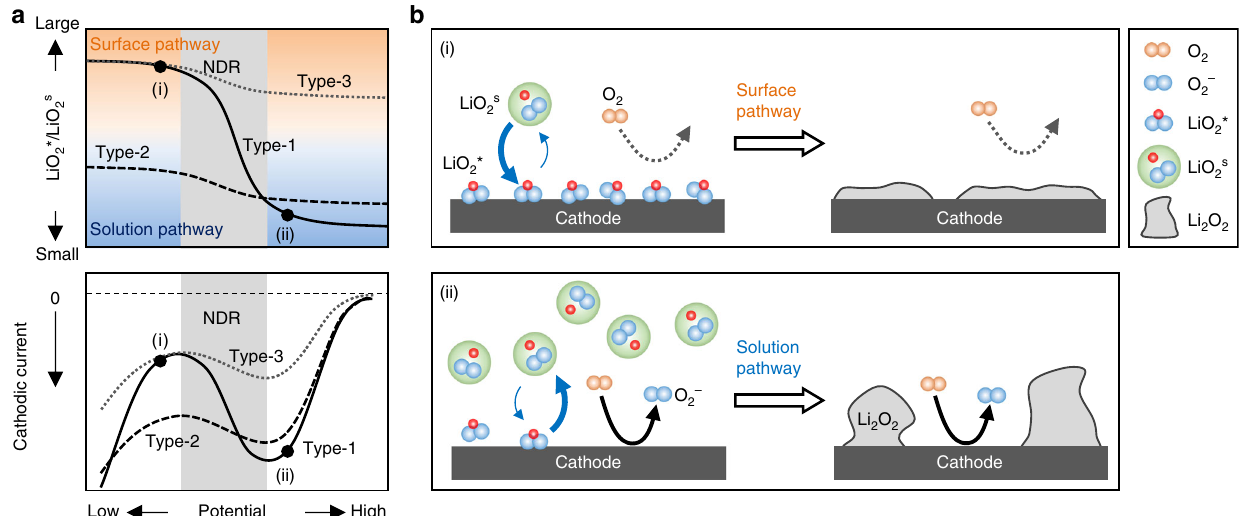
Fig. 6 Schematic illustration of the proposed mechanism for the formation of Li 2 O 2 . a The changes of ratio, LiO 2 */LiO 2 s (above) and cathodic current (below) with potentials. The NDR potential region indicates the transition region of the ratio (LiO 2 */LiO 2 s ) in each system. b The numbers of illustration (i) and (ii) are corresponded with the numbers plotted in a . In the case of Type-1, the surface pathway is dominant at the state (i) of lower potential than the NDR potential region. In contrast, the solution pathway is encouraged at the state (ii) in higher potential region than